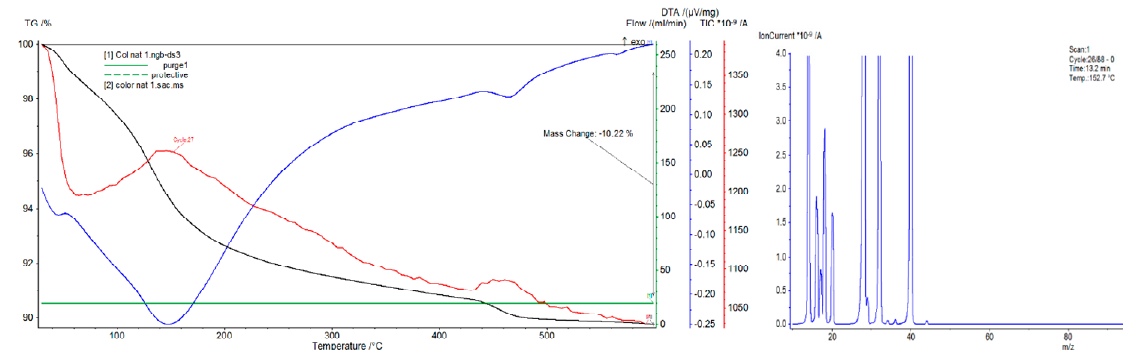
Figure 6. Thermal analysis differential thermal analysis/differential scanning calorimetry (DTA/DSC) of sample 2.